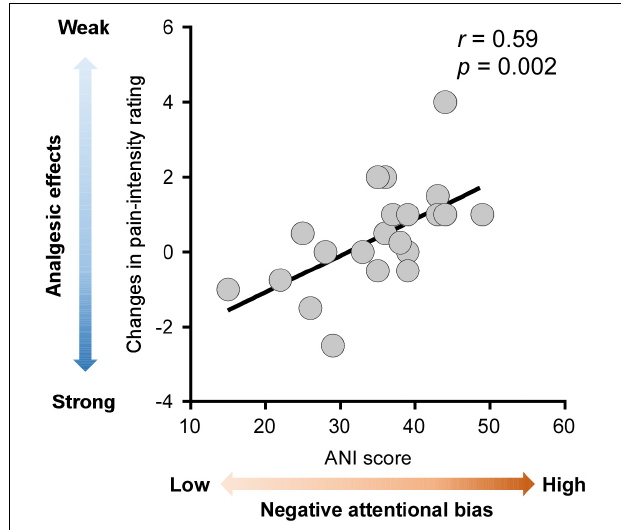
FIGURE 4 | Associations between analgesic effects of anodal high-definition transcranial direct current (HD-tDCS) and negative attentional bias. Analgesic effects of anodal HD-tDCS over M1 on cold pain intensity rating were calculated as the contrast between anodal and sham stimulation condition (anodal HD-tDCS minus sham HD-tDCS), with more negative values indicating stronger analgesic effects (colored in darker blue). The negative attentional bias was quantified by the scores on the Attention to Negative Information Scale (ANI), with greater scores on the ANI indicating a higher level of negative attentional bias (colored in darker red). Across all participants, stronger analgesic effects of anodal HD-tDCS were significantly correlated with a lower level of negative attentional bias. Each gray dot in the scatter plots represents a single participant. The black line represents the best linear fit for the data.